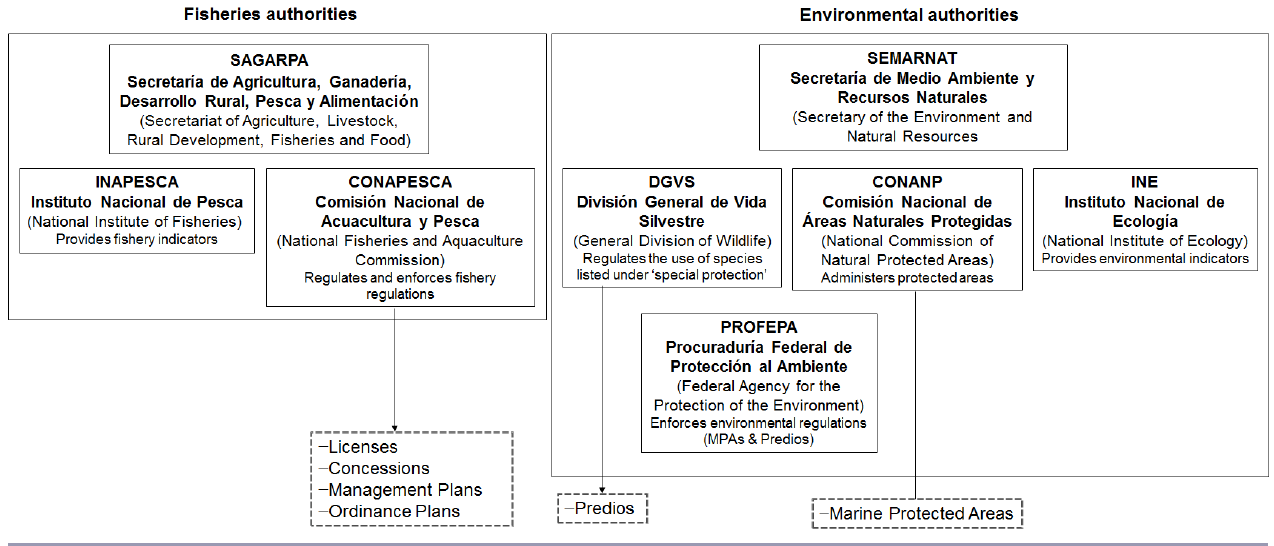
Fig. 3 . Federal agencies involved in fisheries regulation in